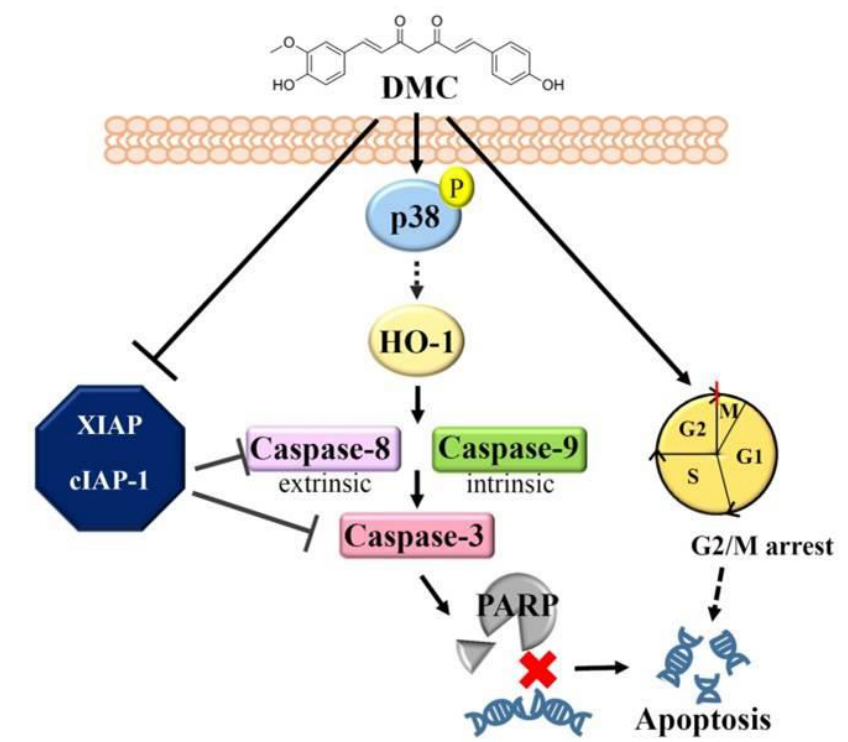
Figure 6. A working model shows the molecular mechanism underlying the ability of demethoxycurcumin (DMC) to suppress the growth of oral squamous cell carcinoma (OSCC) cells. The antiproliferative activity of DMC against OSCC cells derived from primary and metastatic sites was attributed to inhibition of cellular inhibitor of apoptosis 1 (cIAP1)/X-chromosome-linked IAP (XIAP) expression and activation of the p38 mitogen-activated protein kinase (MAPK)-heme oxygenase (HO)-1 axis, with the ultimate induction of apoptotic cell death. Moreover, the induction of G2/M arrest might be another cause for the DMC-induced apoptotic cell death in OSCC cells. Supplementary Materials: The following are available online at www.mdpi.com/xxx/s1, Figure S1: Effect of demethoxycurcumin (DMC) on apoptosis-related proteins in oral squamous cell carcinoma (OSCC) cells, Figure S2: Activation of p38 mitogen-activated protein kinase (MAPK) is involved in demethoxycurcumin (DMC)-induced heme oxygenase (HO)-1 expression and cell apoptosis in SCC9 cells, Figure S3: Levels of endogenous epidermal growth factor receptor (EGFR) were analyzed by Western blot analysis in HSC-3 and SCC-9 oral squamous cell carcinoma (OSCC) cells, Figure S4: Demethoxycurcumin (DMC) potentiates the growth inhibitory effect of gefitinib on oral squamous cell carcinoma (OSCC) cells.